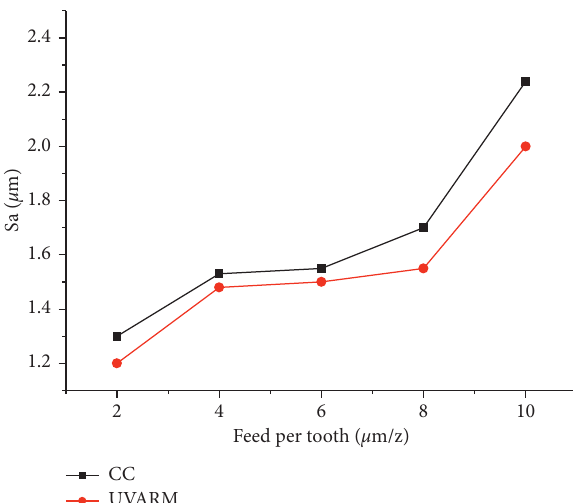
Figure 24: The behavior of surface roughness with the change of feed per tooth.